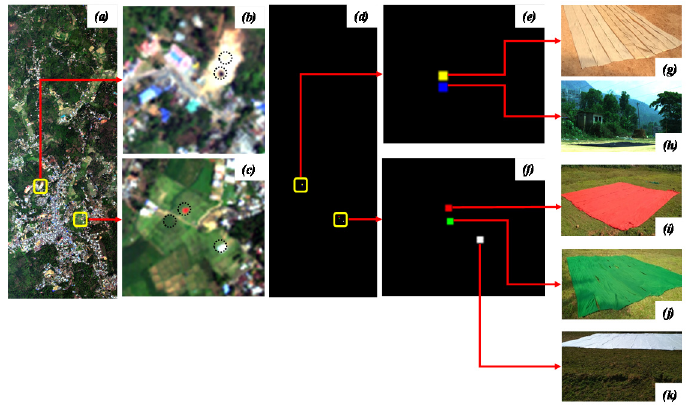
Figure 2. ( a ) True color composite of the AVIRIS-NG hyperspectral imagery with the locations of the artificial targets earmarked; ( b ) location of targets—N3Y and N4B; ( c ) location of targets—C1W, N1G, and N2R; ( d ) ground truth map, and ( e – f ) enlarged view of the ground truth map for different targets. Field photographs ( g – k ) showing the artificial targets placed in the study area for imagery acquisition.